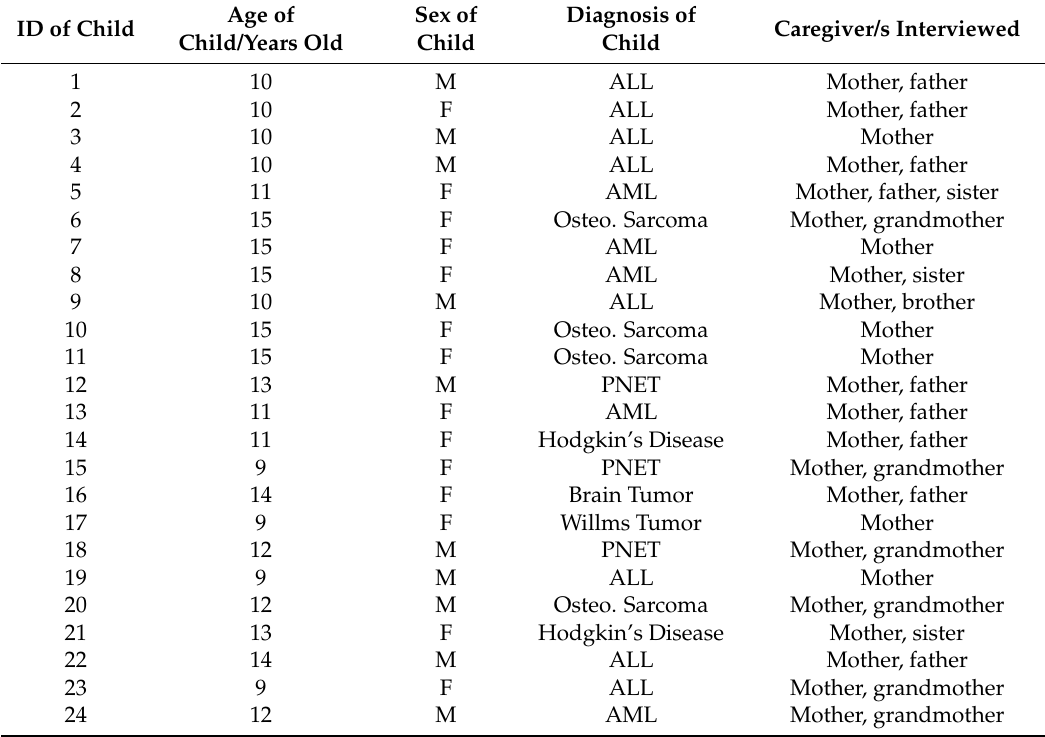
Table 1. Basic characteristics of the caregivers and their